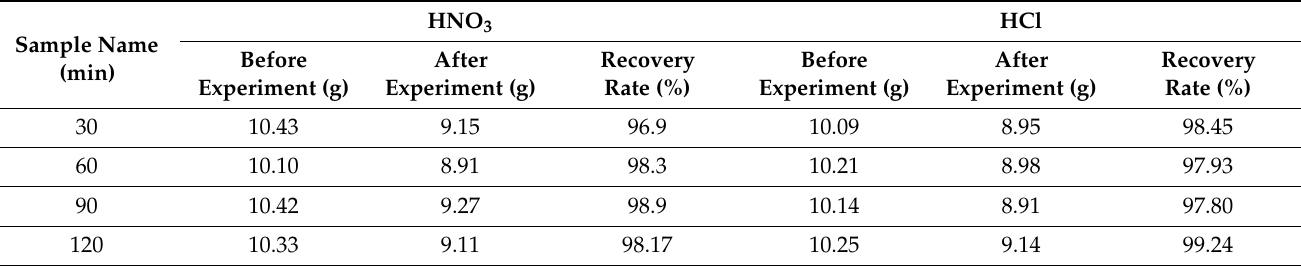
Table 9. Change in the photovoltaic cell weight before and after experiment and Si recovery